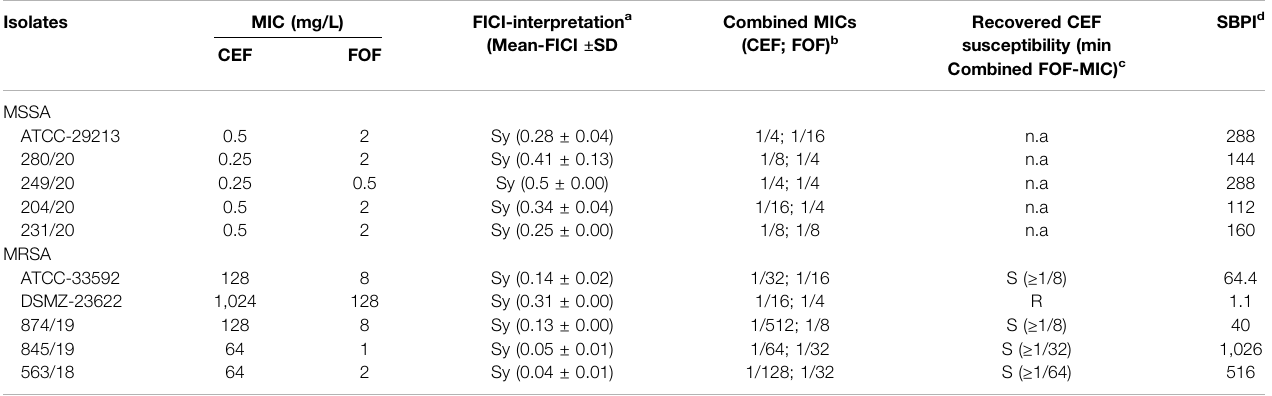
TABLE 1 | Summary of in vitro susceptibility and synergy testing.